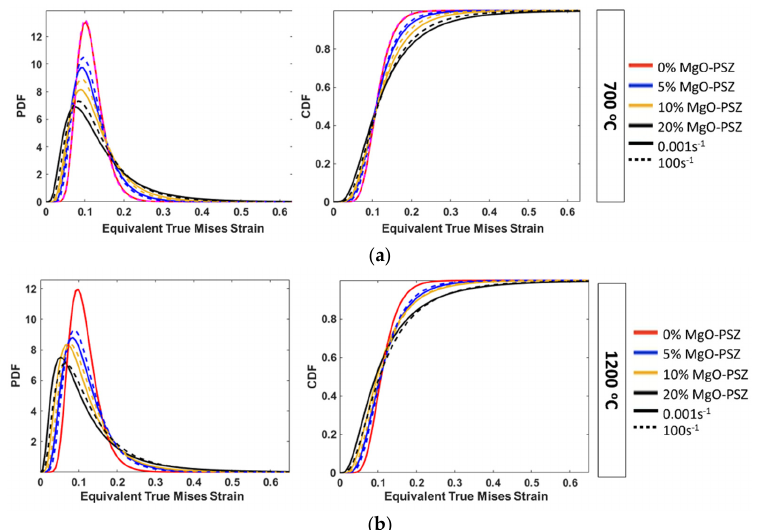
Figure 12. PDF and CDF for austenite grains against true strain at 0.1 global strain and ( a ) 700 °C and ( b ) 1200 °C.